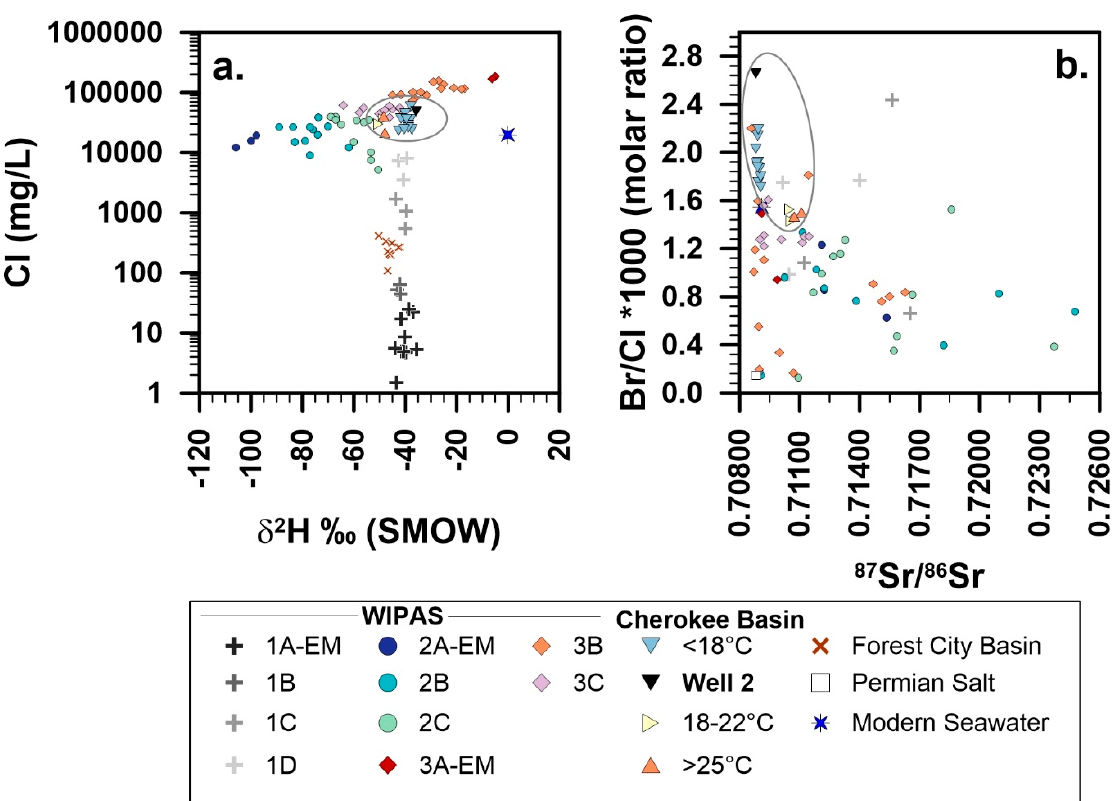
Figure 7. Regional geochemical context for Cherokee Basin fluids sampled in this study in comparison with Cambrian–Ordovician and Mississippian units of the Western Interior Plains Aquifer System (WIPAS) [55,74] and Pennsylvanian units of the Forest City Basin [63]. Cherokee Basin fluids sampled for this study are circled for reference. For both Cl vs. δ 2 H ( a ) and Br/Cl vs. 87 Sr/ 86 Sr ( b ), geochemical groups and endmembers (EM) for the WIPAS are as defined by Musgrove and Banner [55]. The salt sample is from a group of dissolution mine wells targeting the Permian Hutchinson Salt Member west of the study area [75]. Well 2 is representative of the new end-member proposed in this work. In ( a ), SMOW is standard mean ocean water.